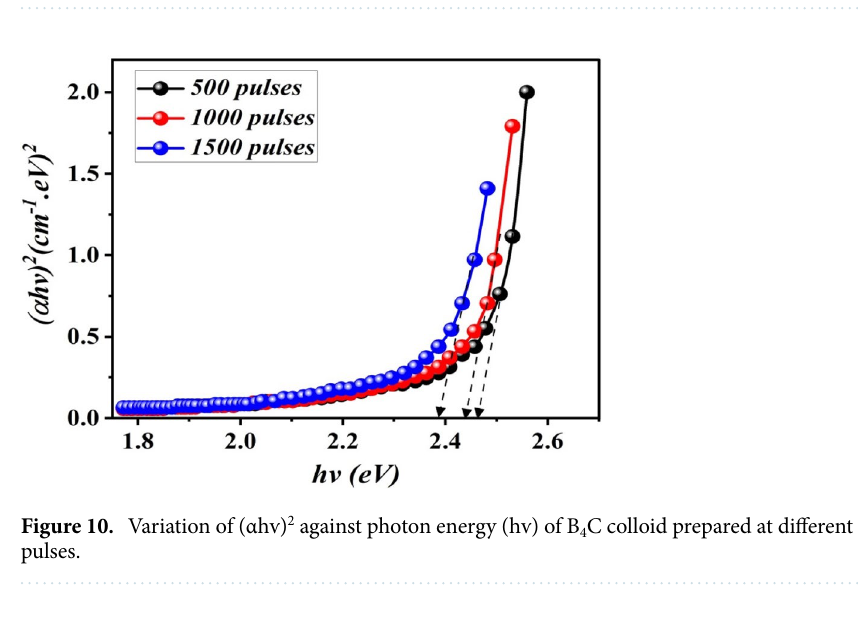
Figure 9. Optical absorption of B 4 C colloid prepared at different number of laser pulses. Inset is the photograph of B4C colloid prepared at different number of laser pulses.